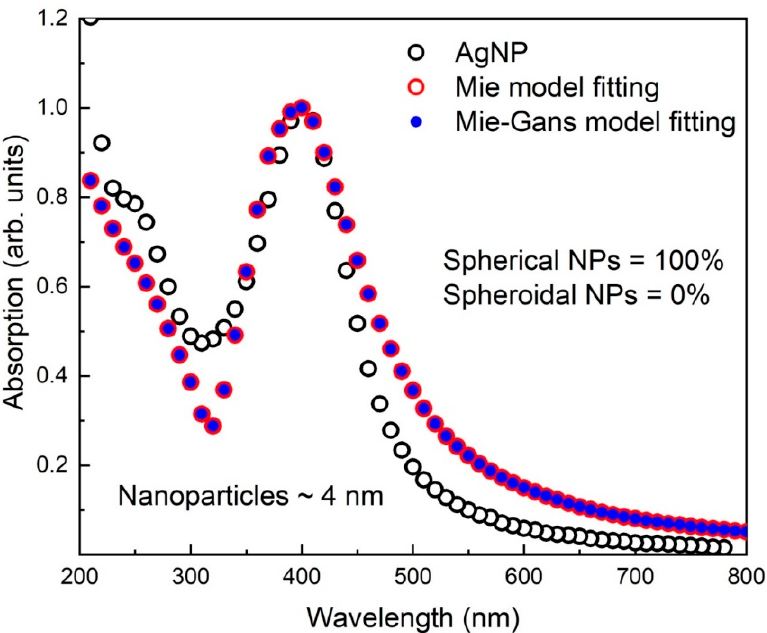
Figure 4. Absorption spectrum of the SPR max normalized AgNPs and its fitting with the Mie and Mie Gans models. Fitting models deduce the morphology of the particles as spherical and their size approximately 2 nm.